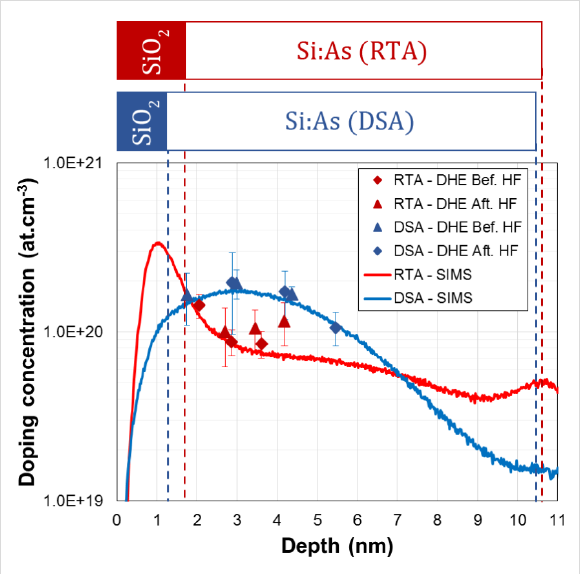
Figure 10: Active dopant concentration depth profiles as extracted by DHE measurements from 11 nm thick SOI wafers implanted with As + (3 keV, 1 × 10 14 cm − 3 ) and annealed with spike-RTA (red symbols) or millisecond-laser-DSA (blue symbols). DHE values are compared with the corresponding arsenic chemical concentration profiles as measured by